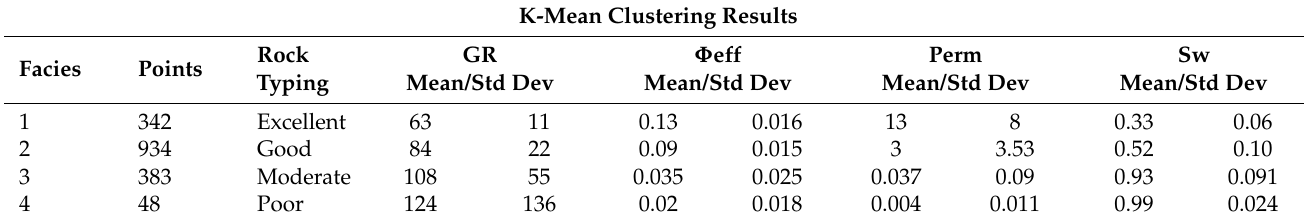
Table 4. Results of cluster assessment for each rock type.